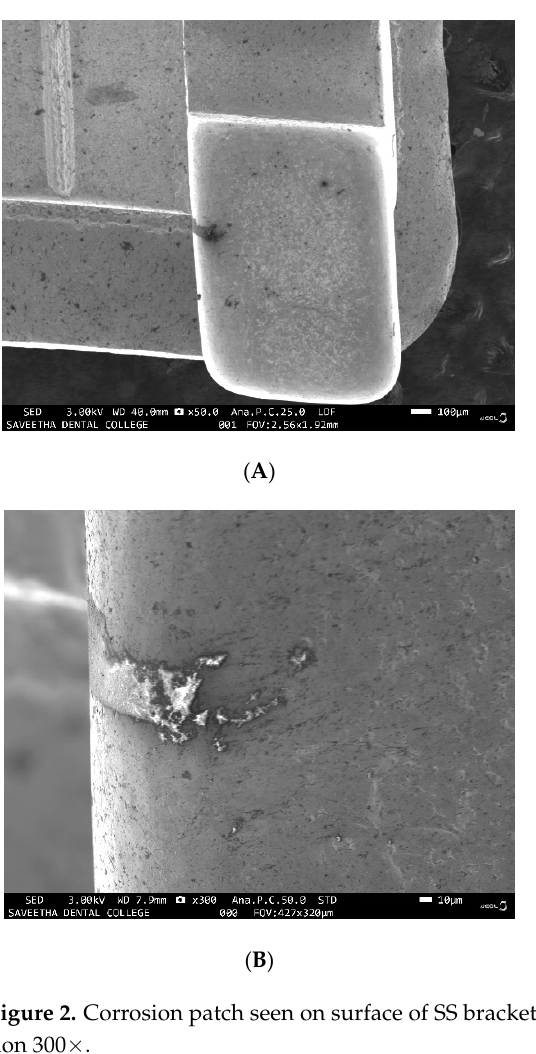
Figure 2. Corrosion patch seen on surface of SS bracket under ( A ) low 50× and ( B ) high magnifica- tion 300×.